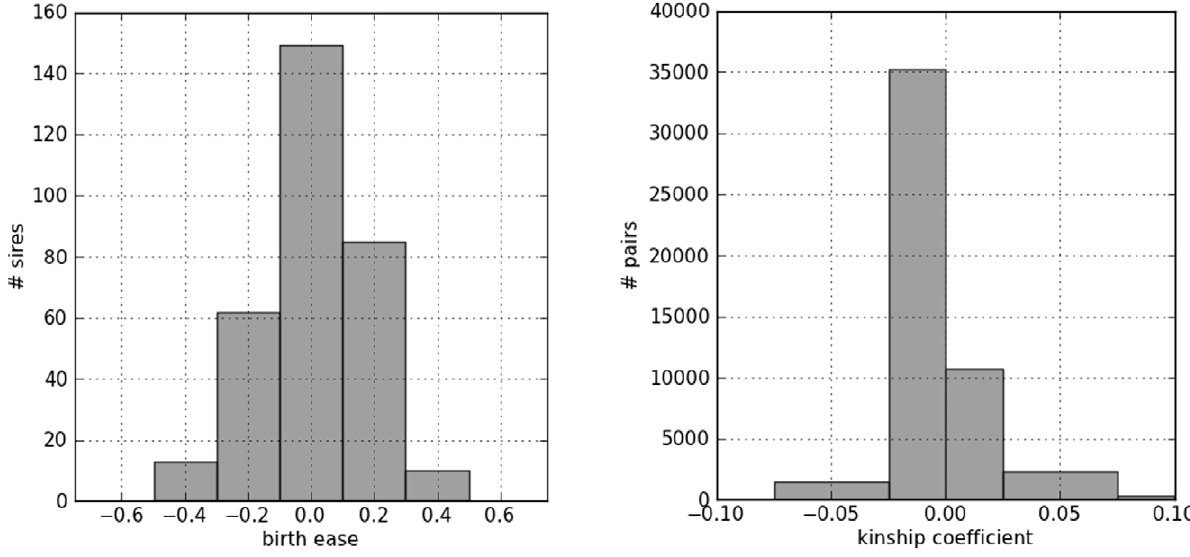
Figure 1. Left Panel: histograms of EBVs for direct calving ease distributed in five equally spaced classes. Right panel: histogram of kinship coefficients between sires in five equally spaced classes. In both panels, the number of sires belonging to each class is plotted as a function of classes.